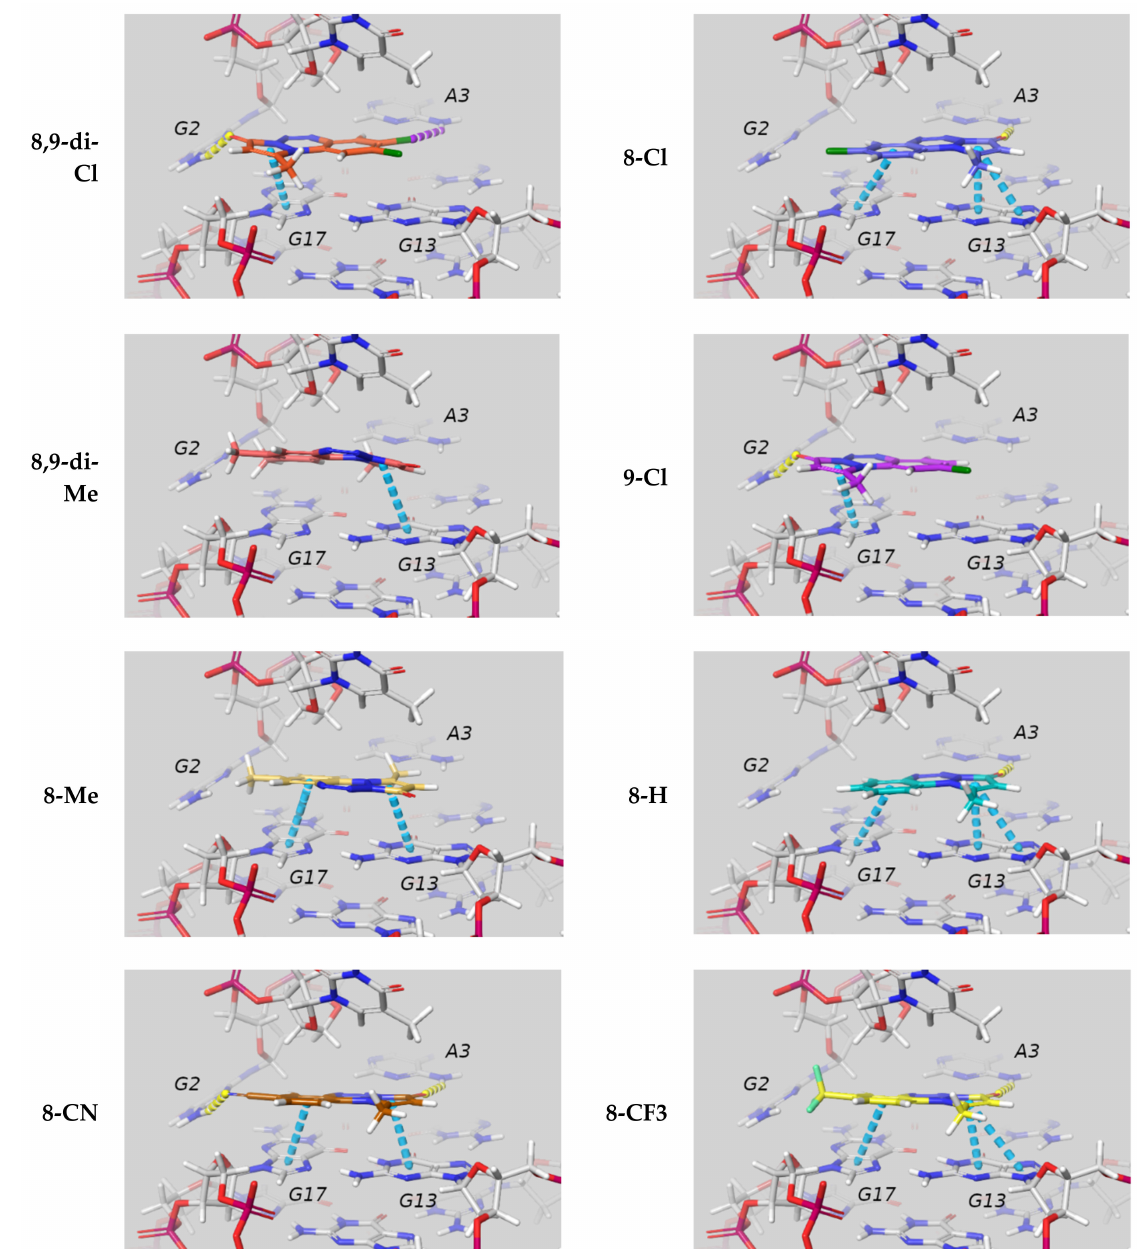
Figure 6. Interaction with the GQ c-myc, in the best pose according to the MMGBSA dG bind. The ligands are all located at the 5 (cid:48) end of the GQ. Dashed lines highlight specific interactions according to the following color code depending on the nature of the interaction: hydrogen bond (yellow), π - π (light blue), and halogen bond (purple). For artistic purposes, the Carbon atoms of the ligand vary the color with the ligand, while the Hydrogen atoms are white, Oxygen red, Nitrogen blue, Fluorine light green, Chlorine green, and the carbon atoms on DNA are light